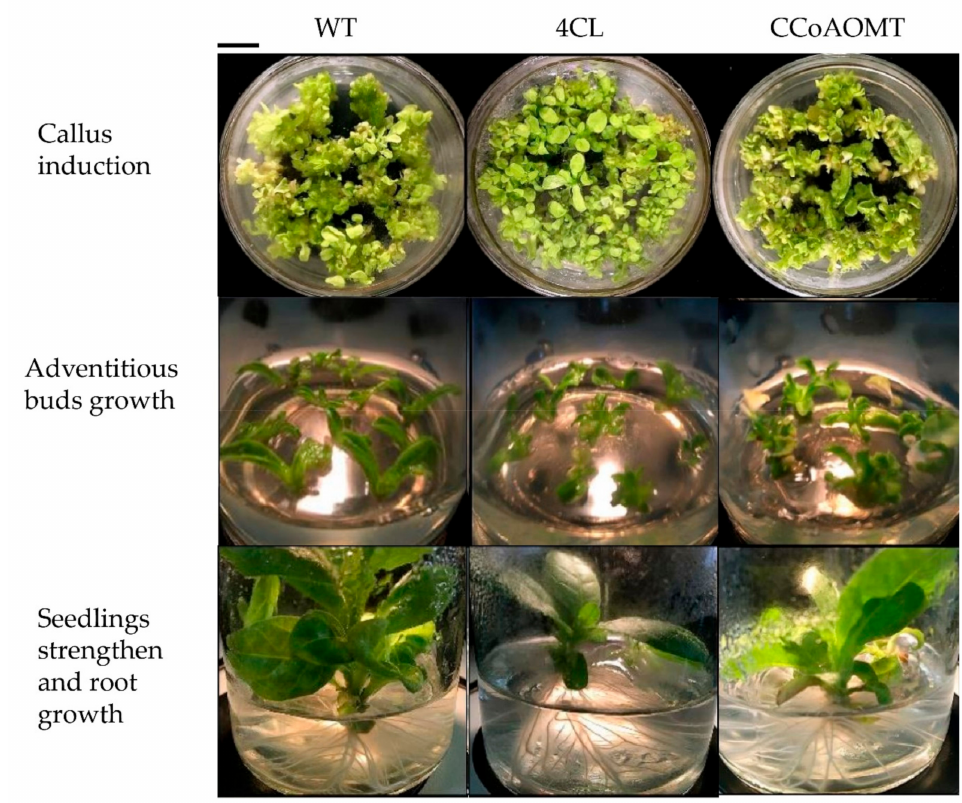
Figure 8. Overexpression of Cf4CL and CfCCoAOMT initially impedes tobacco growth. The first to third columns show representative images of wild type, Cf4CL transfected, and CfCCoAOMT transfected leaves, respectively. The first to third rows successively show the callus induction, adventitious bud growth, and seedling strengthening / root growth phases. A total of 3 seedlings were randomly chosen for measurements of each genotype. Bar equals 1